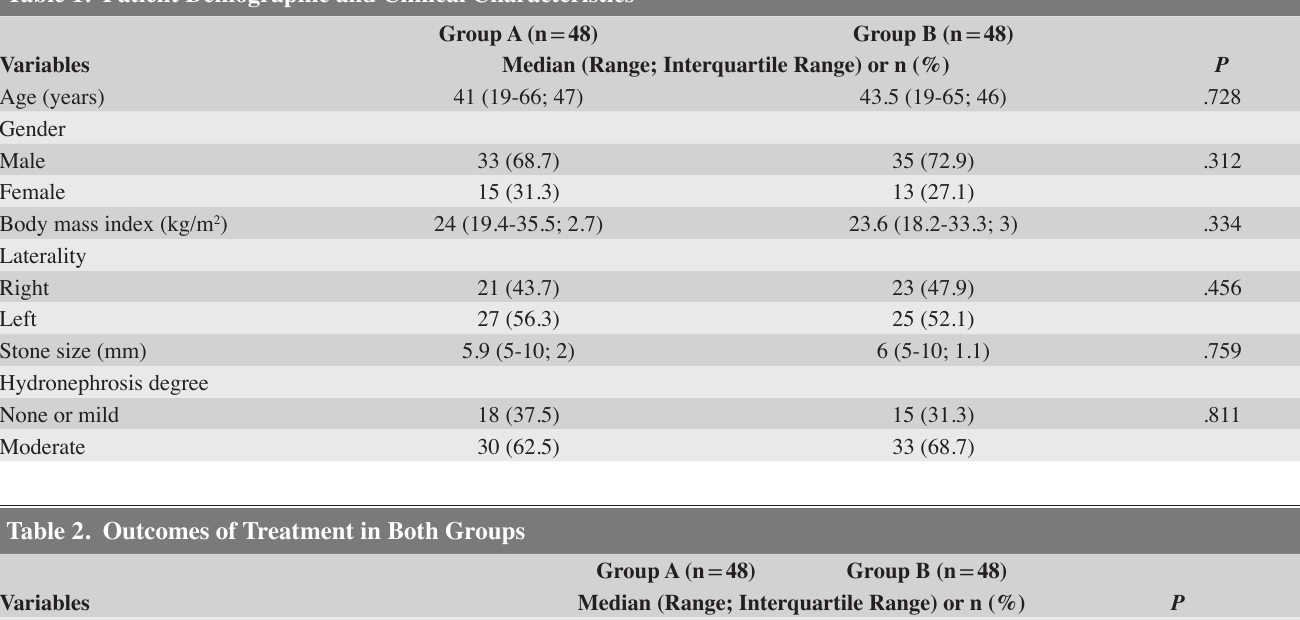
Table 1. Patient Demographic and Clinical